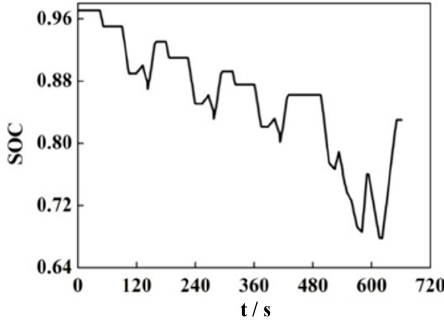
Figure 10. SOC curve of supercapacitors in the typical strategy.